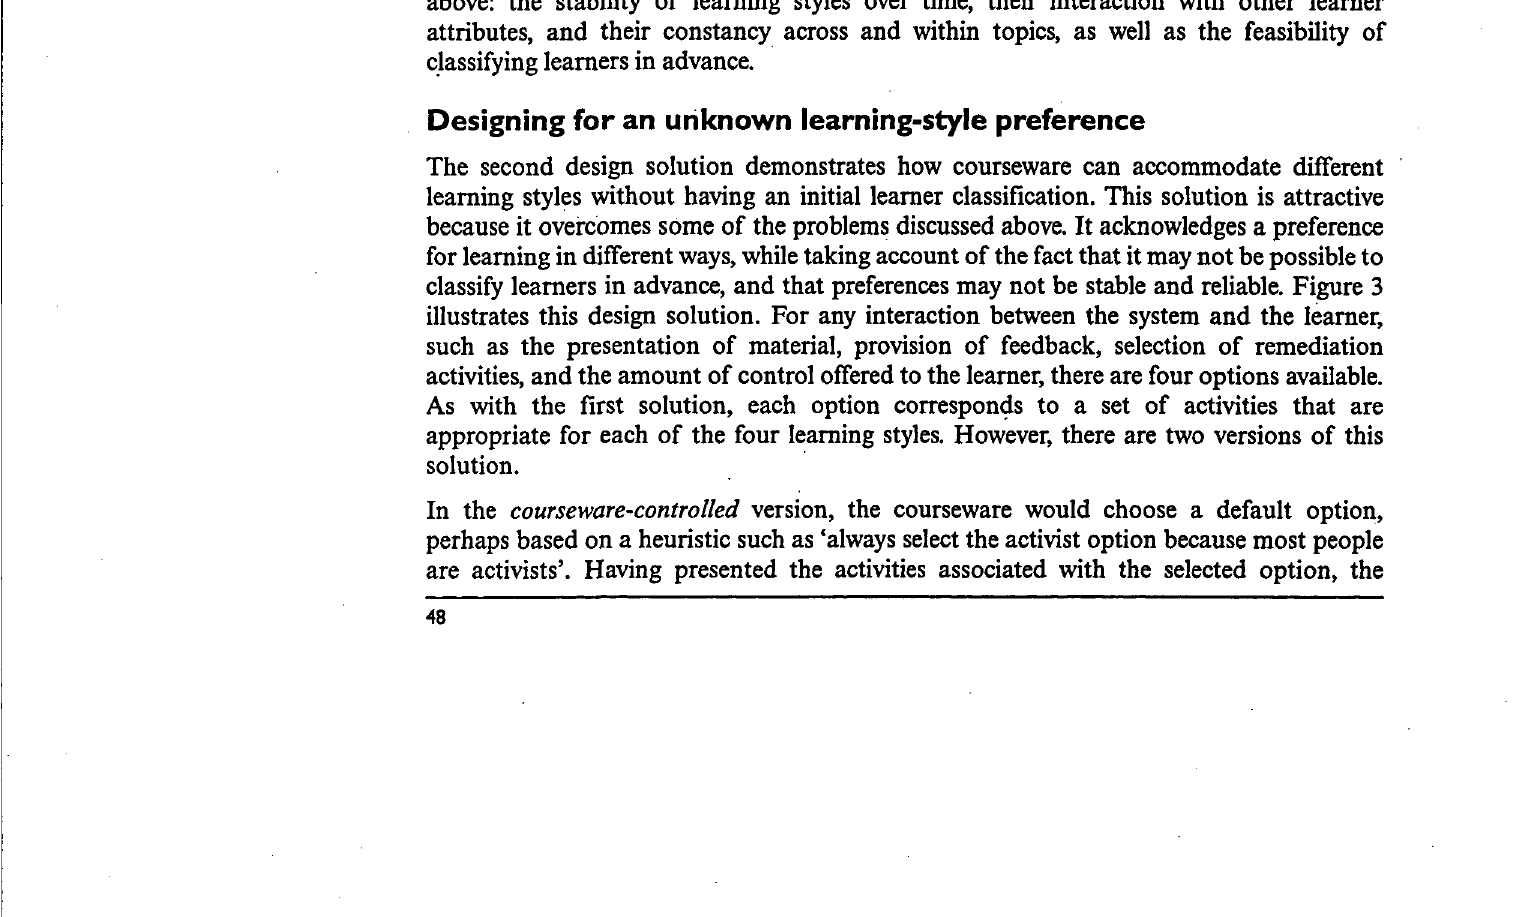
figure 2: Courseware design example where preferred learning style is